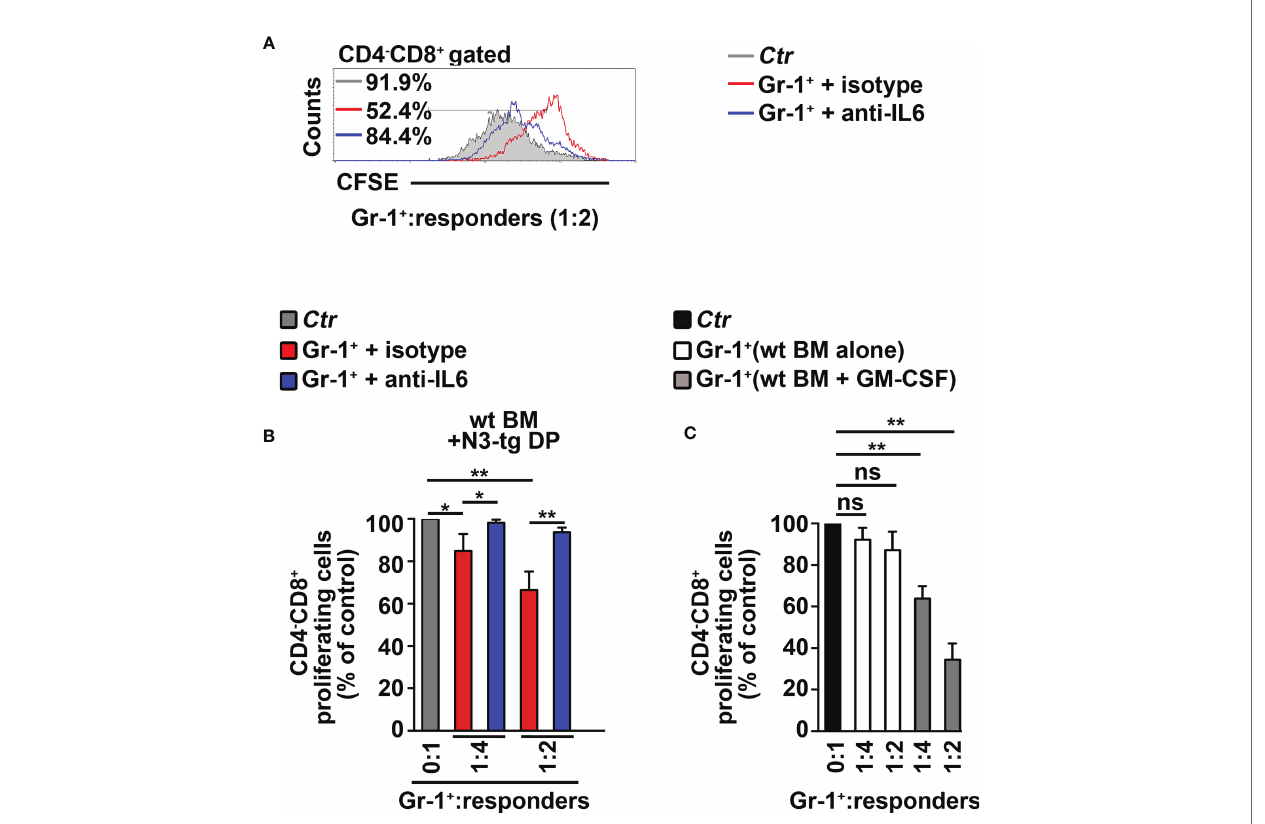
FIGURE 3 | CD4 + CD8 + (DP) T cells from N3-tg mice drive in vitro differentiation of MDSCs through IL-6. (A) Representative FACS analysis of suppression assay with CFSE/activated wt T splenocytes ( “ responders ” ), cultured either alone (Ctr), as a control, or in combination with Gr-1 + cells (Gr-1 + ), at the indicated Gr-1 + / responders ratio. Numbers inside cytograms indicate the percentages of proliferating wt CD4 − CD8 + T responder cells. Gr-1 + cells were magnetically selected from 5- day cocultures of total wt BM cells with DP T cells from BM of N3-tg , in the presence of anti-IL-6-neutralizing antibodies (blue line) or isotype controls (red line), and by using transwell inserts. In (B) , the results of the same suppression test, as in (A) , are illustrated as mean values ± SD from multiple experiments, see below. (C) The suppression test was performed by using wt T responder cells cultured either alone (black bar), as a control, or in combination with Gr-1 + cells (Gr-1 + ), selected, as above, from total wt BM cells cultured in medium alone or supplemented with GM-CSF (white bars and gray bars, respectively), for 5 days, and used at the indicated Gr-1 + :responders ratios. In (B, C) , the results are calculated as the ratio between percentages of proliferating CD4 − CD8 + T responder cells in Gr-1 + -